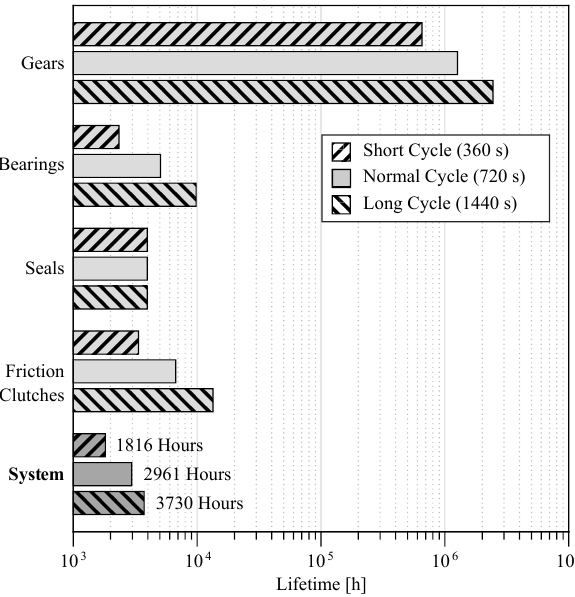
Figure 13: Influence of cycle